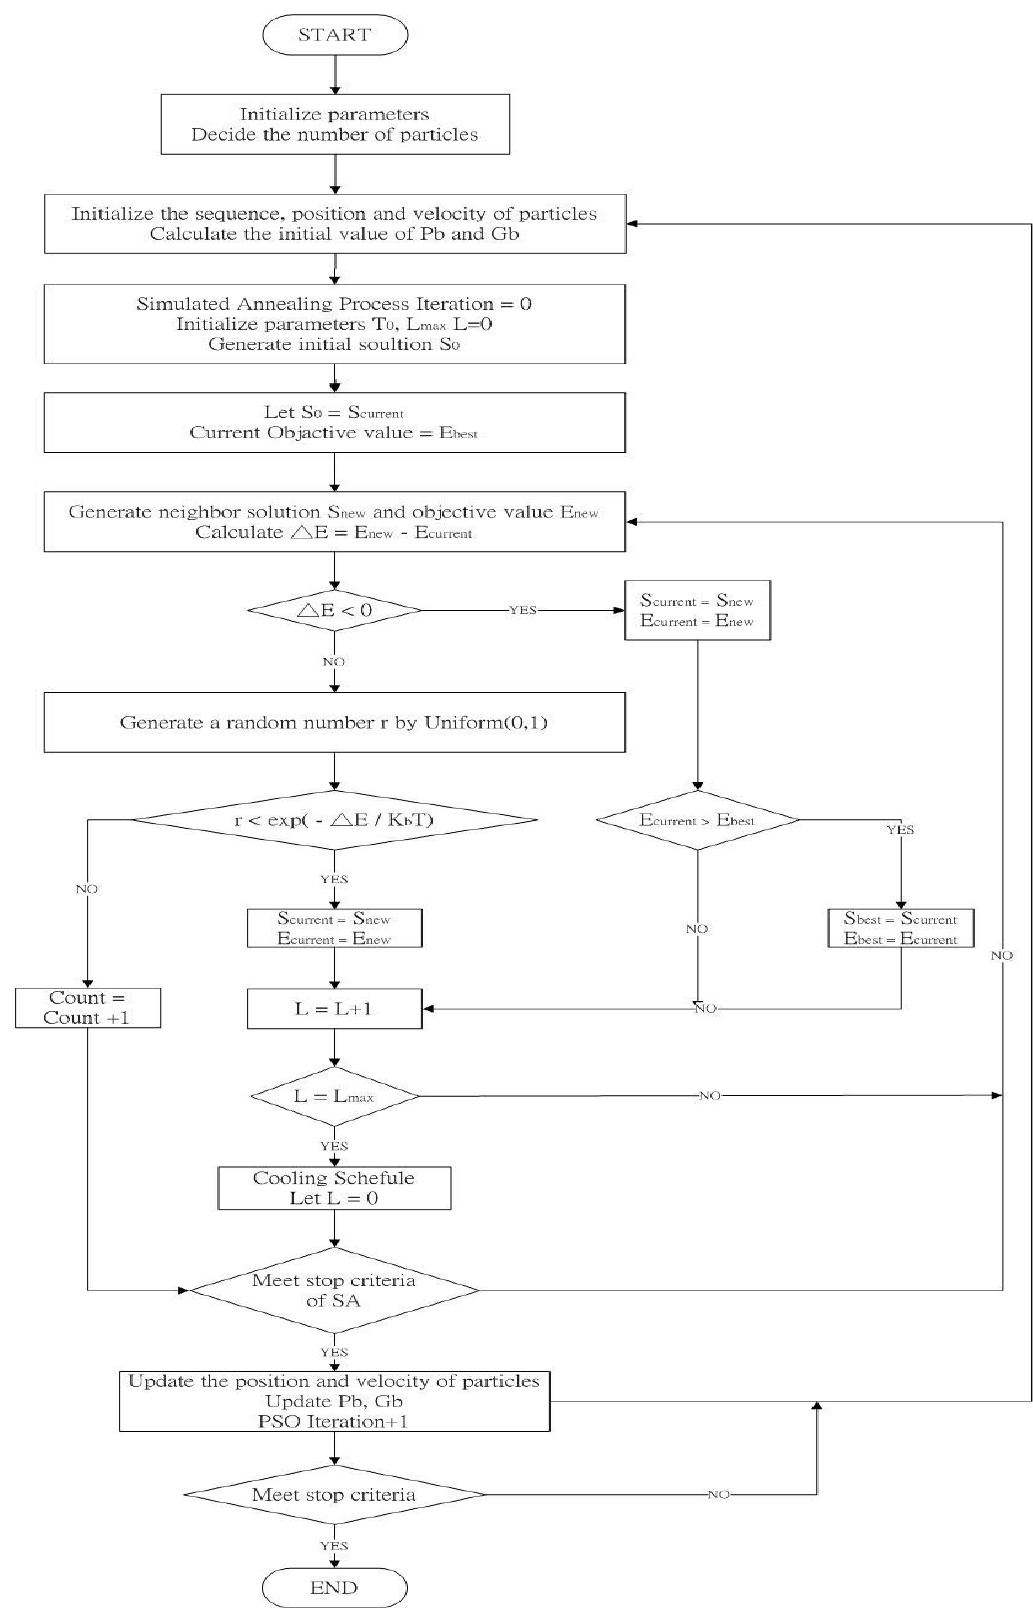
Figure 6. PSO + SA.